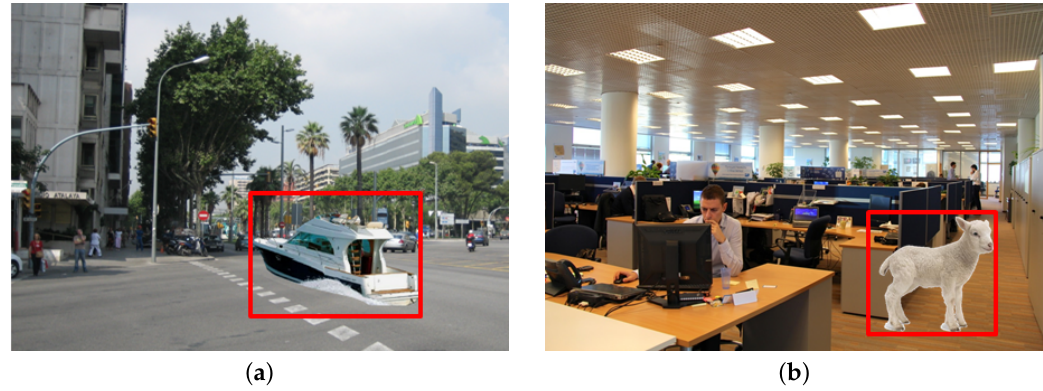
Figure 1. Examples of image forgery detection based on contextual abnormality. The manipulated parts (areas in the red box) can be detected because these objects caused contextual abnormalities. ( a ) a boat surrounded by cars and trees constitutes a contextual abnormality, ( b ) the presence of the lamb in the office is quite an unusual